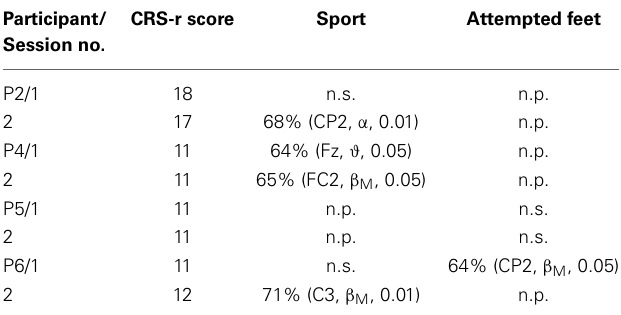
Table 3 | Summary of results for the post-hoc offline detection of different tasks for the online feedback paradigm.